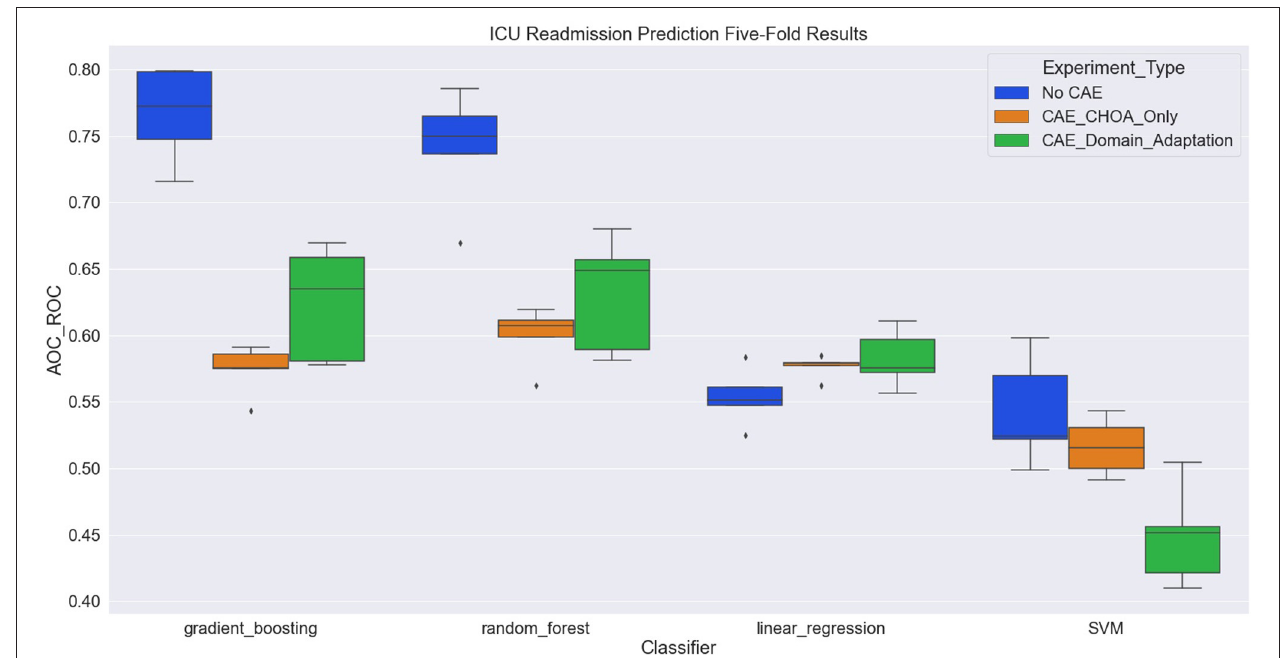
Frontiers in Artificial Intelligence |